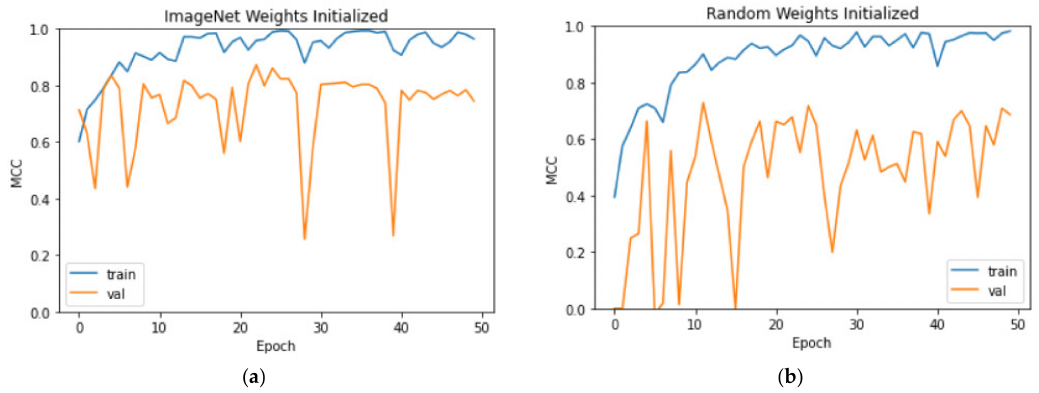
Figure 10. MCC curves with ( a ) TL-WI, and ( b ) RWI.